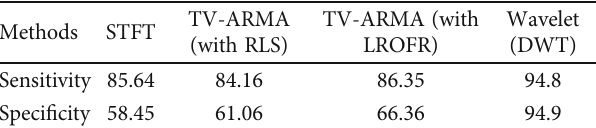
Table 5: Sensitivity and speci fi city comparison of DWT with di ff erent approaches. Methods